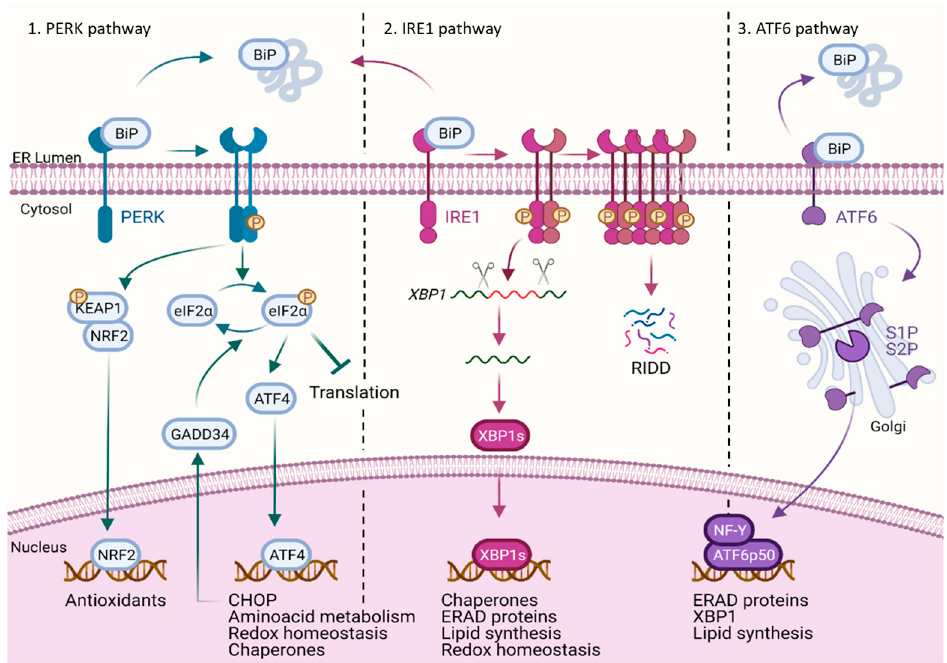
Figure 1. The three branches of unfolded protein response. In response to intra/extracellular stressors, protein folding capacity of ER is disturbed. BiP binds to the misfolded proteins in the lumen of the ER and sets the three UPR sensors PERK, IRE1 α , and ATF6 free in the meantime. PERK dimerizes, autophosphorylates and then phosphorylates eIF2 α . Protein synthesis will then be transiently inhibited in order to alleviate ER protein burden, except for specific mRNAs, such as ATF4. PERK may also dissociate KEAP1 from NRF2. IRE1 dimerizes and trans-autophosphorylates, activating its RNase domain to splice XBP1 mRNA into the more stable version, known as XBP1 mRNA, which encodes a potent transcription factor. IRE1 can degrade a subset of mRNAs through RIDD as well. ATF6 translocates to the Golgi where it is cleaved, and then its p50 cytoplasmic fragment heterodimerizes with NF-Y. Consequently, genes involved in ERAD, redox homeostasis and coding various chaperones are transcribed, first attempting to reverse the trend of protein folding turbulence and conserve the cells from dying.